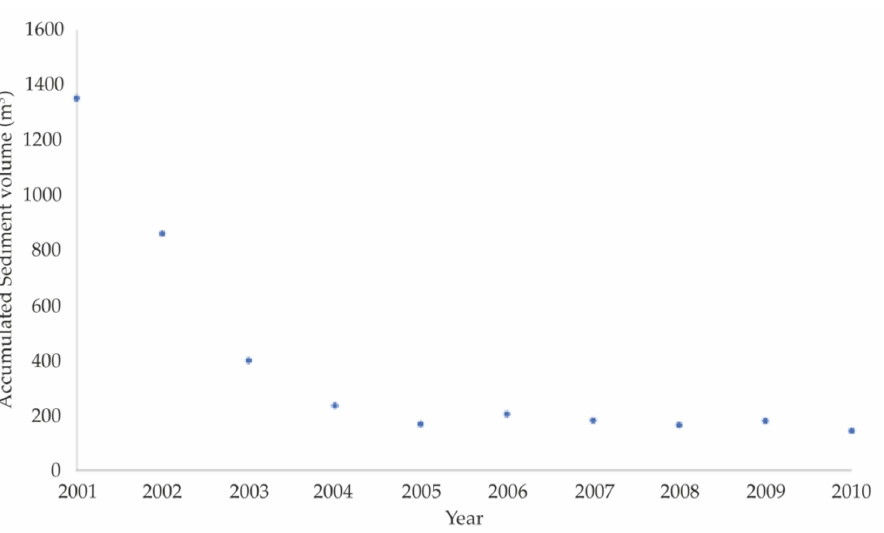
Figure 14. Annual sediments volumes accumulated in GC and obtained from the 10-year modelling.